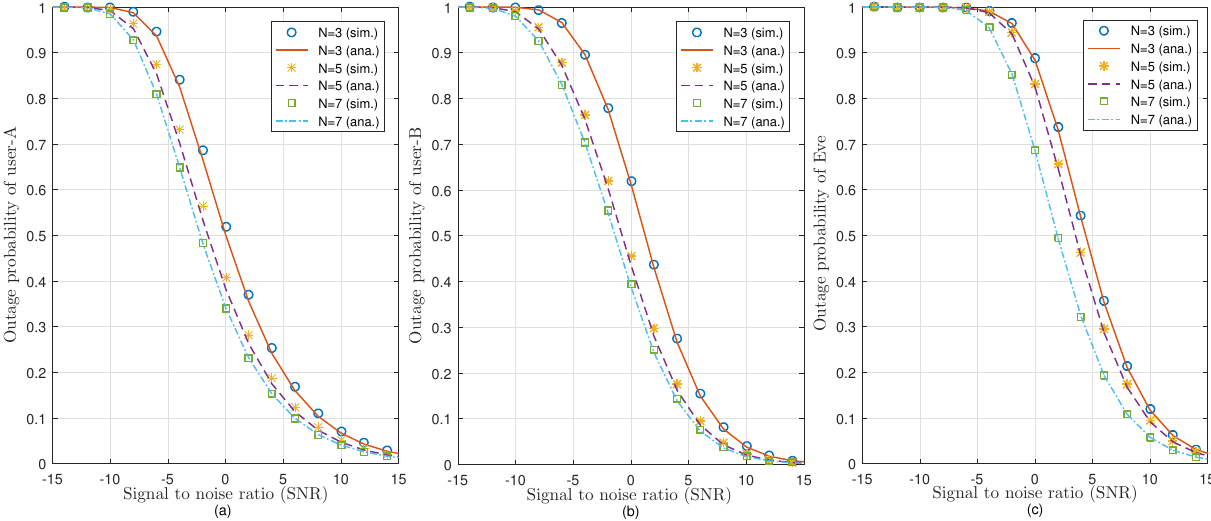
Figure 3. Effect of different values of BS transmit antennas on the outage probability of ( a ) user-A, ( b ) user-B, and ( c ) Eve, against SNR in